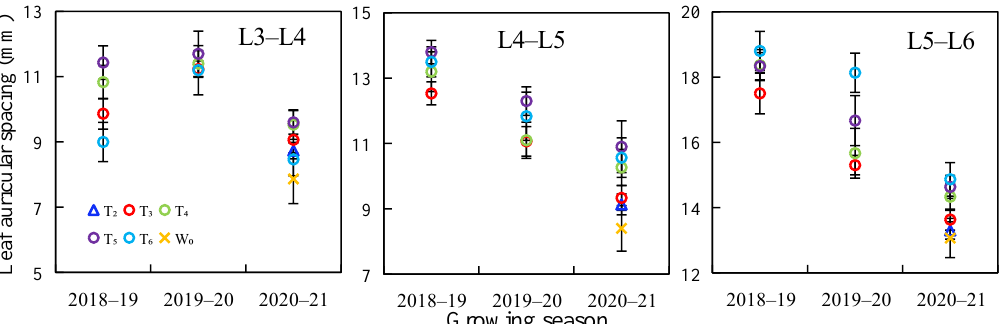
Figure 8. Leaf auricular spacing for different treatments in each wheat growing season. L3 – L4, L4 – L5, and L5 – L6 represent the spacing from the third leaf auricle to the fourth leaf auricle, from the fourth leaf auricle to the fifth leaf auricle, and from the fifth leaf auricle to the sixth leaf auricle, respectively. T 2 was not set in the growing seasons from 2018 to 2019 or 2019 to 2020, and W 0 was set only in the growing season from 2020 to 2021.